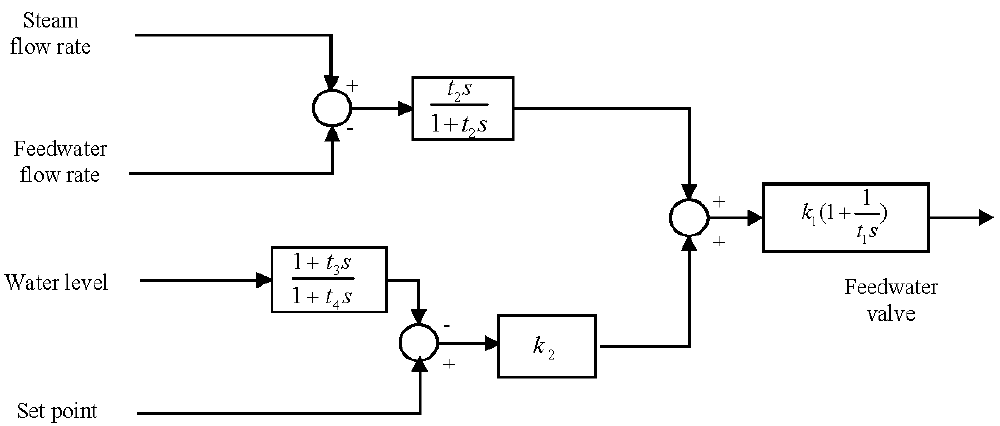
Figure 4. Outline of AP1000 water level control system.